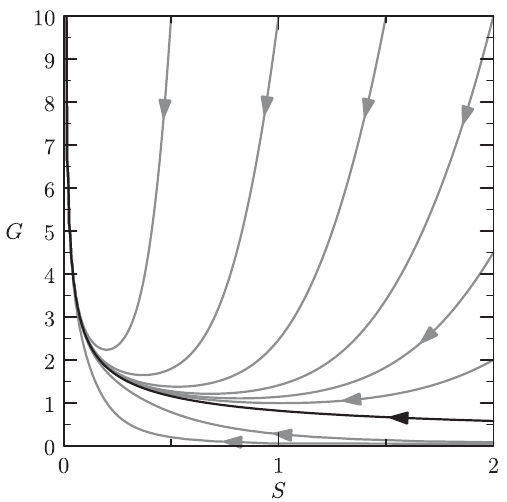
FIG. 2. The dependence of (a) (cid:6) and (b) I by solving the exact Eq. (1) (black solid lines) and by solving the approximate Eqs. (21) and (22) (red dashed lines) for f ¼ 0 : 1 , (cid:4) 2 ¼ 0 : 5 , n ¼ 10 15 cm (cid:1) 3 and for initial conditions (cid:6) 0 ¼ 2000 , ¼ 0 : 8 , p ¼ 0 R (cid:5); 0 y; 0